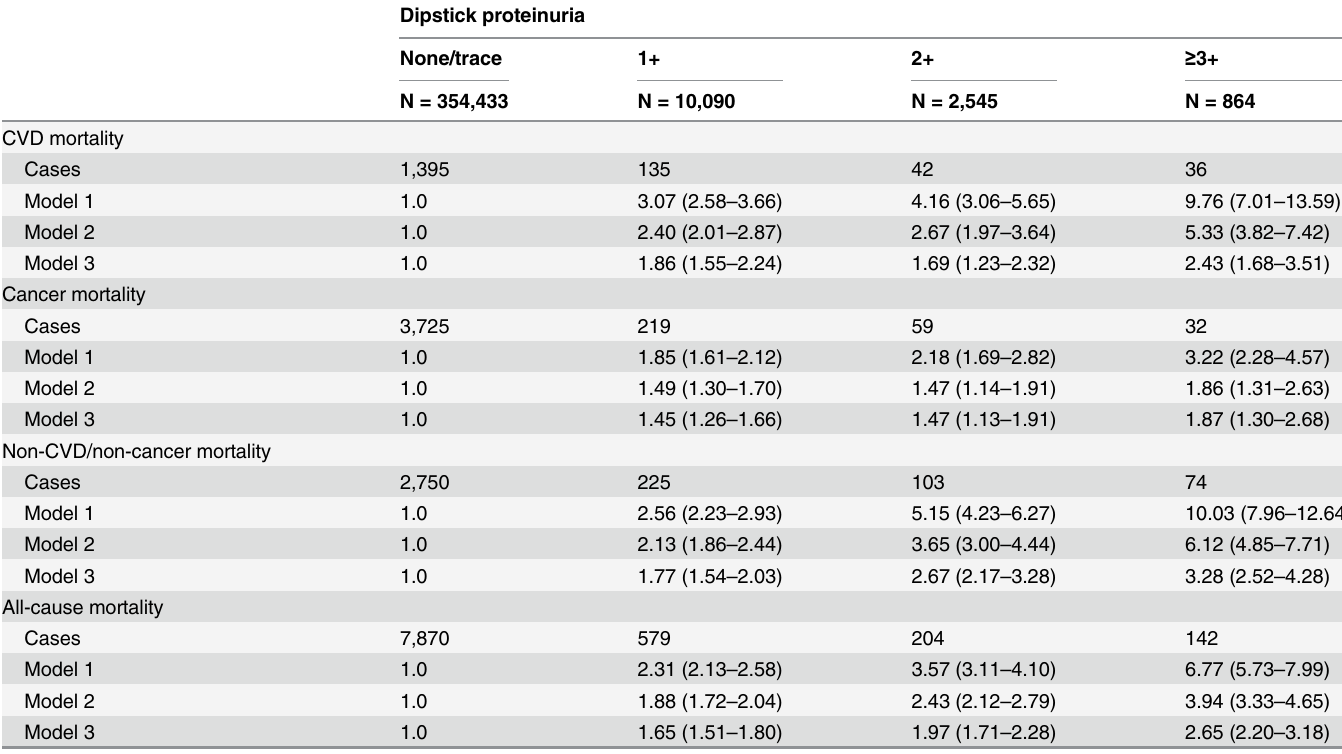
Table 3. Hazard ratios (95%CI) for cause-specific mortality by dipstick proteinuria in Korean Heart